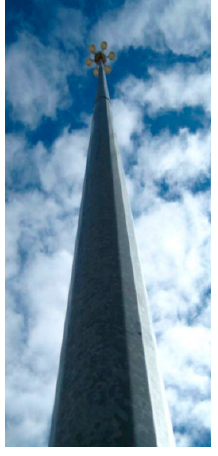
Figure 5. High pole lamp scene diagram.